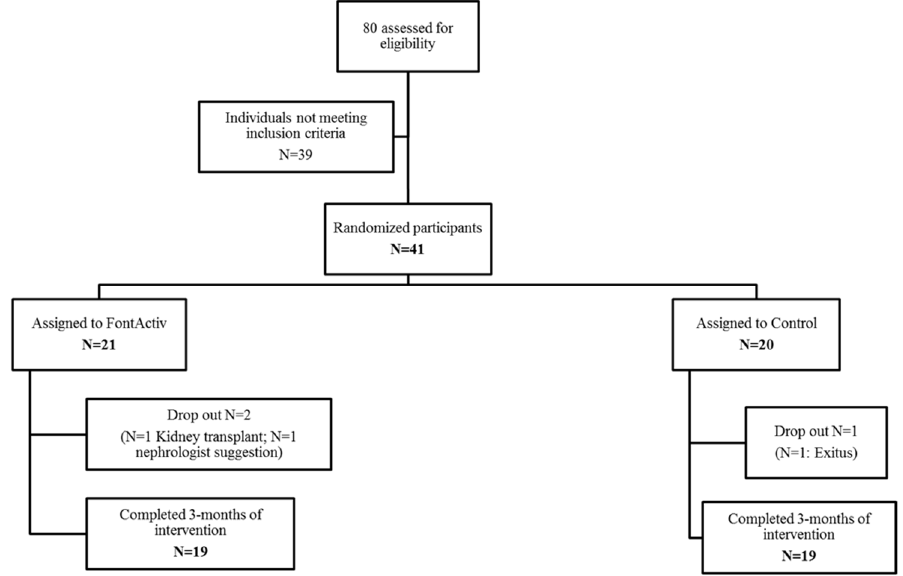
Figure 1. Flowchart of the study.